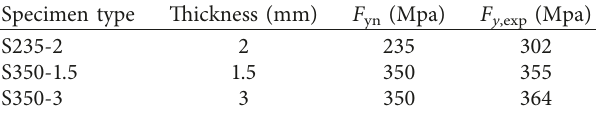
Table 6: Landolfo’s CFS walls coupon test